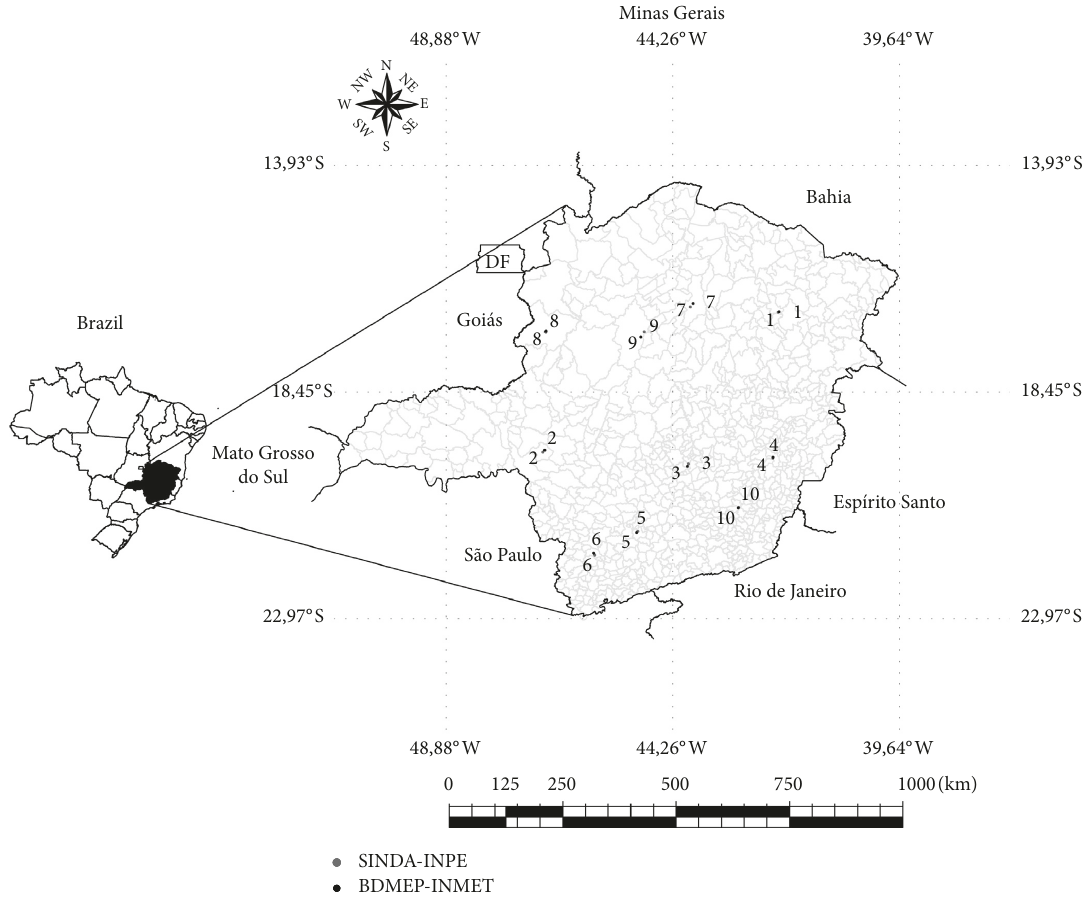
Figure 1: Location of the weather stations used in the